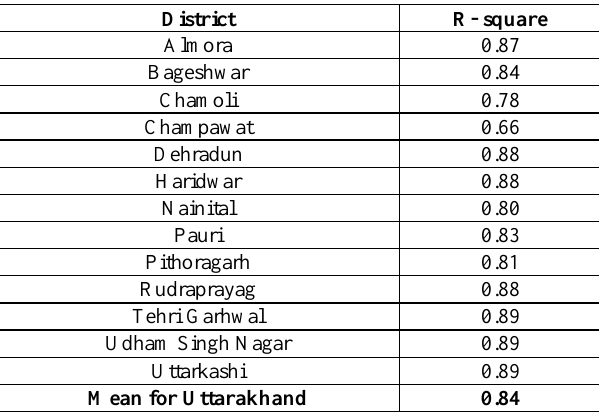
Table 3. Coefficient of determination (R- square) values for burnt area with all the parameters for each district and mean for Uttarakhand The R- square value for Tehri Garhwal, Udham Singh Nagar and Uttarkashi was approximately 0.89 which states that all the independent factors were able to account for the dependent factor i.e. the burnt area while for Champawat, the r- square value was the lowest i.e. 0.66 which implies that more independent variables such as relative humidity, fuel moisture content, dew point temperature etc. are needed to account for the variance in the pattern of burnt area in this